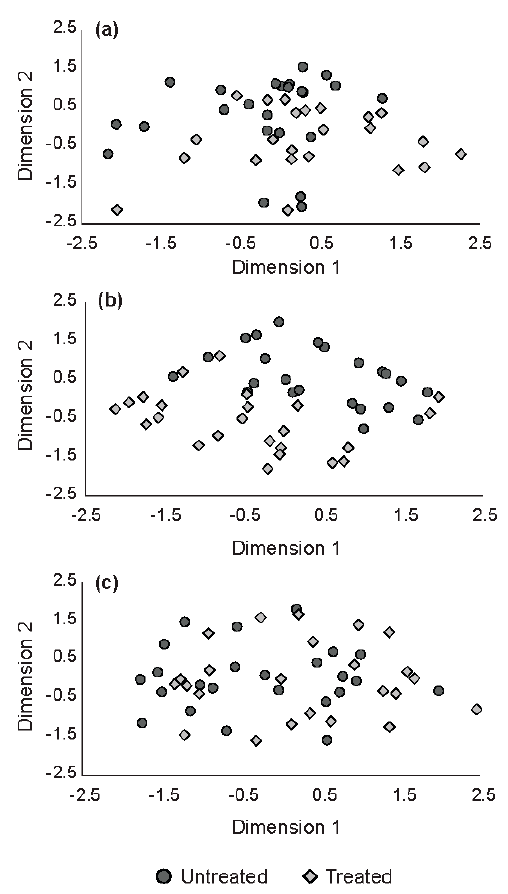
Figure 5. Plots from two-dimensional, non-metric multidimensional scaling (NMDS) analyses. Individual species with discriminatory power across treatments was determined using stepwise discriminant analysis (SDS). Species were considered significant based on a F test having α < 0.05: ( a ) all species; ( b ) four species identified as significant—dewberry ( Rubus pubescens Raf.), blue columbine ( Aquilegia brevistyla Hooker), shrubby cinquefoil ( Dasiphora fruticosa (Linnaeus) Rydberg) and bryophytes; ( c ) all species except four identified as significant.